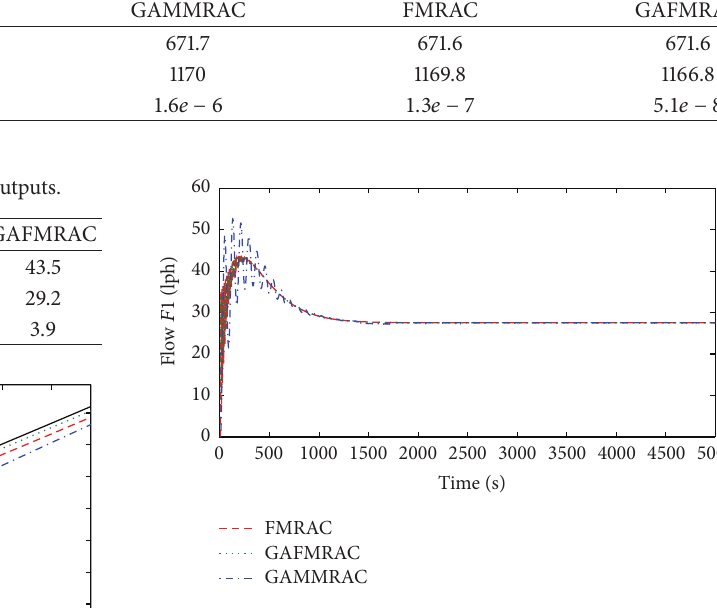
Figure8: Processinputfora stepinputof50tothecommand signal.